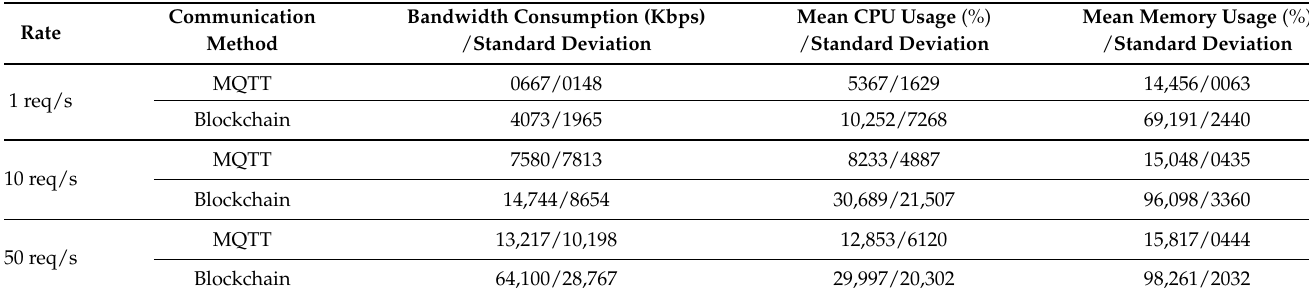
Table 1. Resource consumption results (measured in the sensor controller) for alternative communication approaches. Rate